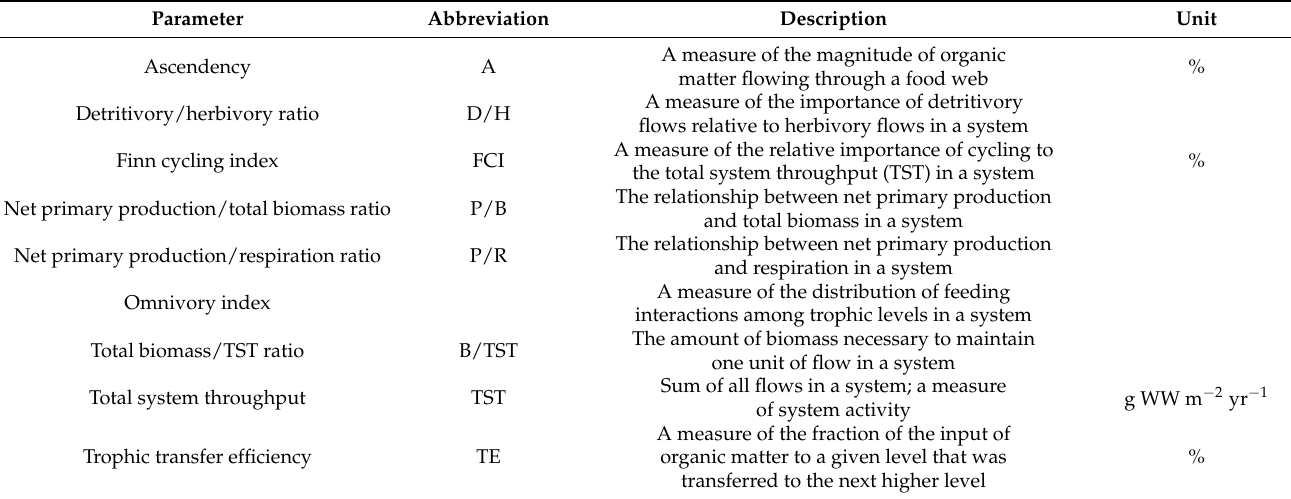
Table 3. Ecosystem parameters of network analysis used to characterize the trophic structure and function of the Dongsha seagrass bed